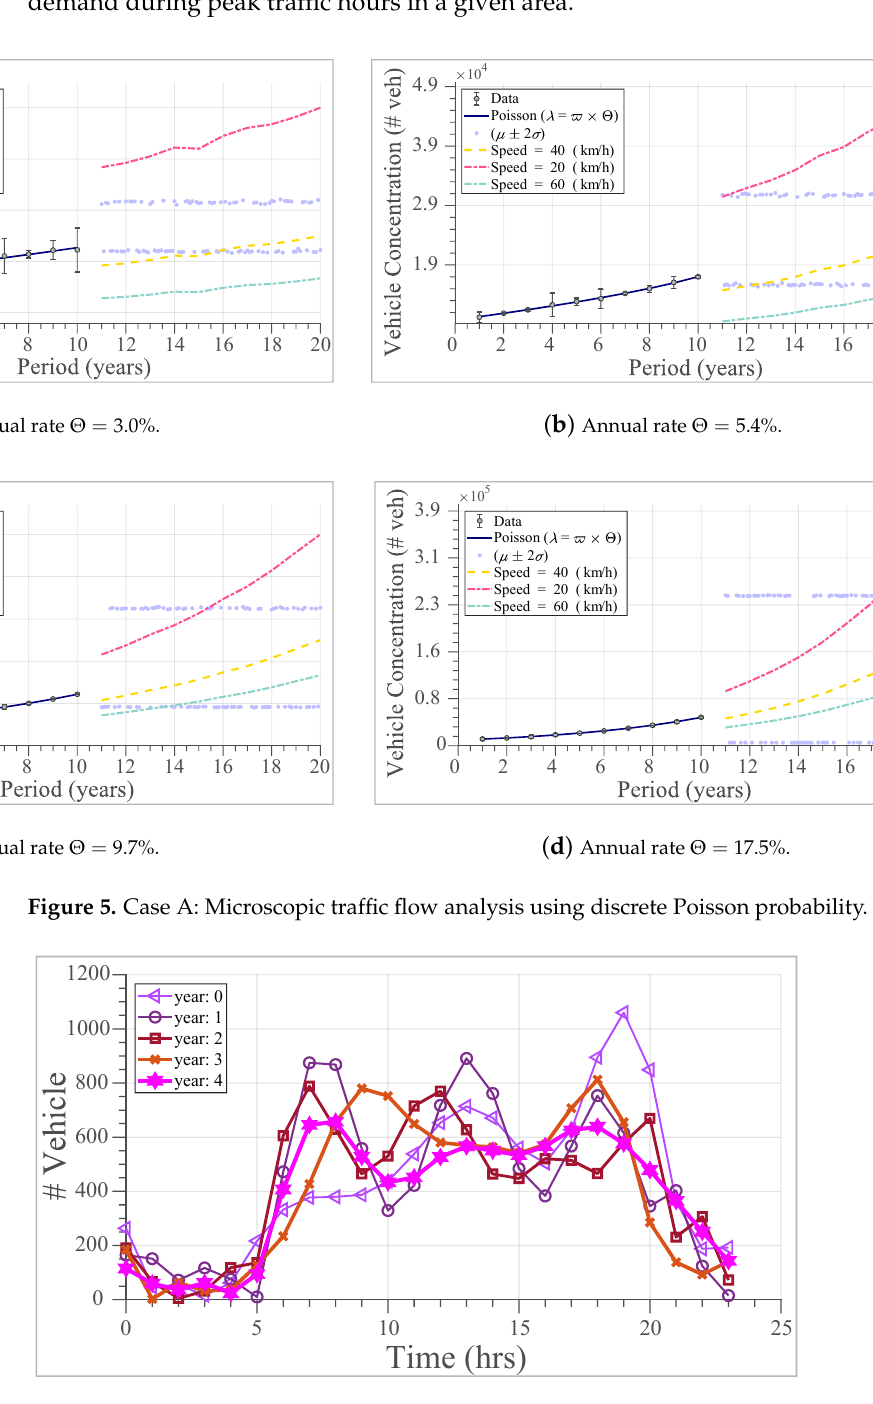
Figure 6. Vehicular traffic scalability with the incremental rate of 3% for case study